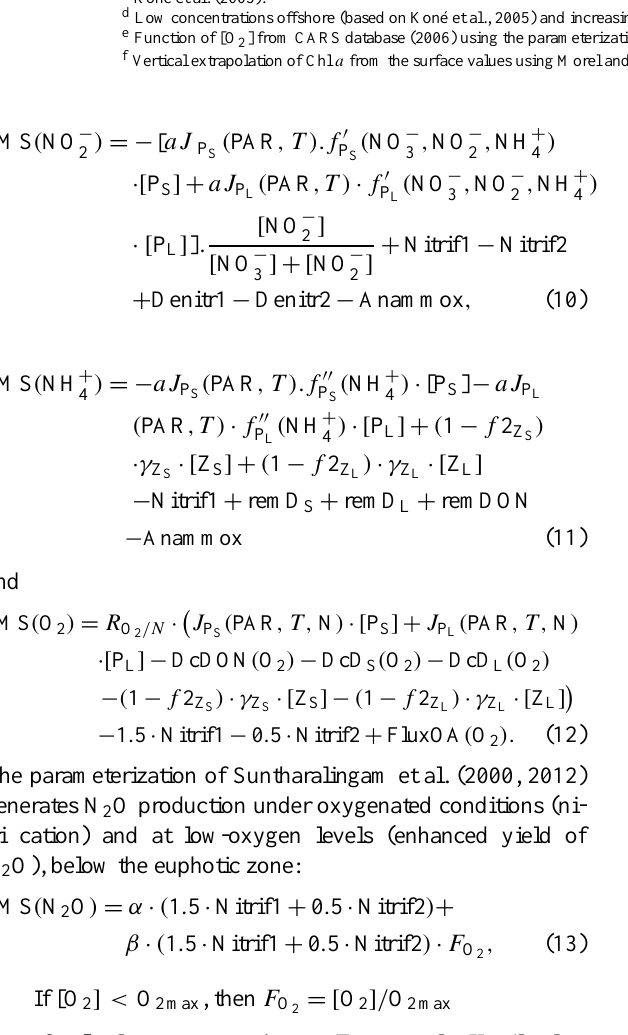
Table 1. BioEBUS biogeochemical model state variables (symbols and units), initial surface values used for the simulation, and scale depth considered for the exponential decrease with depth (for NO − , NH + and DON). 2 4 Symbols Variables Units Initial values Scale depth (m) P S Nanophytoplankton (flagellates) mmolNm − 3 f ([Chl]) a vertical extrapolation f P L Microphytoplankton (diatoms) mmolNm − 3 f ([Chl]) a NO − Nitrates mmolNm − 3 CARS b – 3 NO − Nitrites mmolNm − 3 0.05 2 NH + 4 Mesozooplankton (copepods) Large detritus